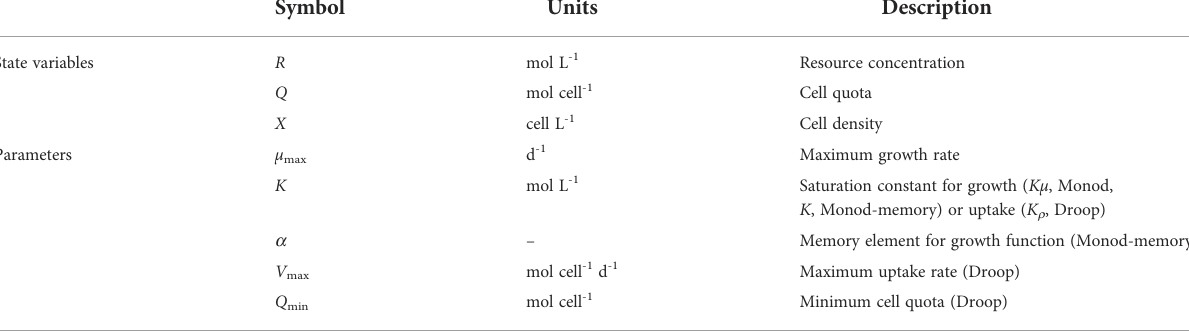
TABLE 1 List of state variables and parameters in Monod, Monod-memory, and Droop